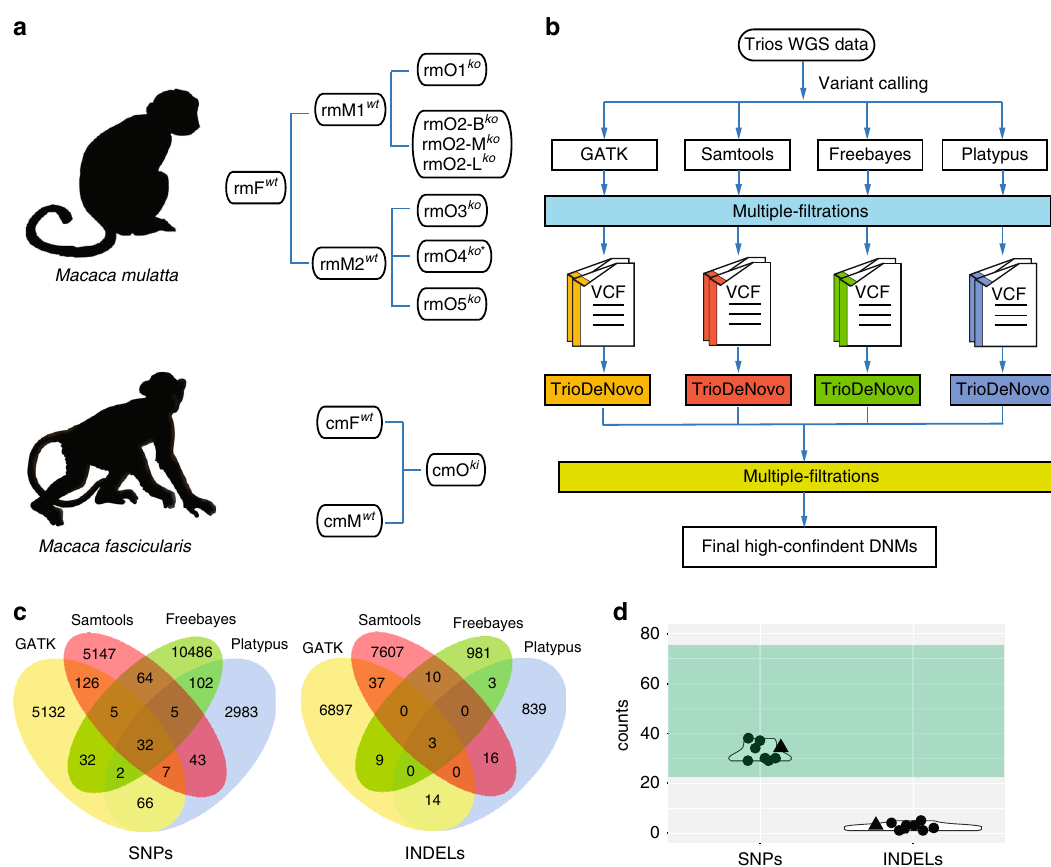
Fig. 1 Detecting de novo mutations (DNMs) in the Cas9-treated monkeys. a The analyzed trios of rhesus monkeys (rm) and cynomolgus monkey (cm). F father, M mother, O offspring, ko knockout, ki knockin, B brain, L liver, and M muscle. b The pipeline of variant calling, fi ltering, and DNMs identi fi cation. HC.DNM-high con fi dent DNMs. c Venn diagram of the high-con fi dent DNMs for rmO2-B ko identi fi ed by overlapping candidate DNMs from four different calling tools. d Summary of the identi fi ed high-con fi dent DNMs. The circles refer to Ca9-treated rhesus monkeys and the triangle refers to the Ca9-treated